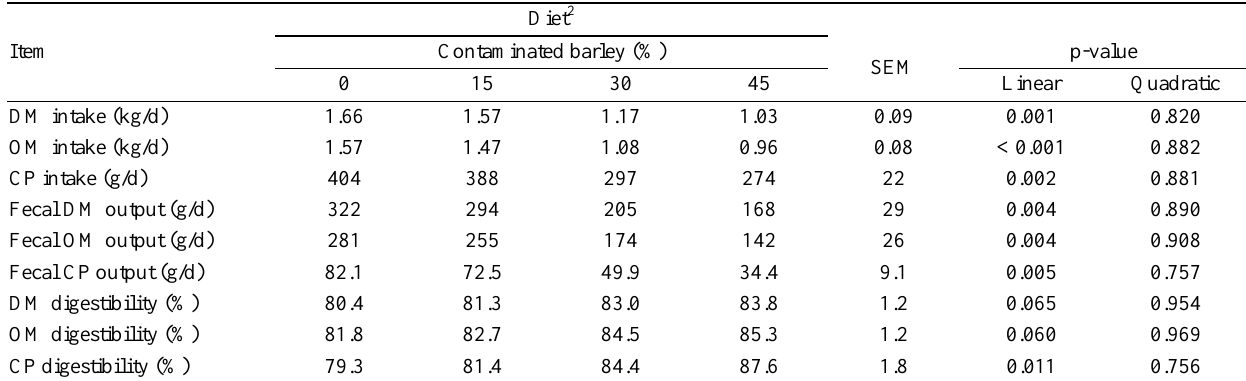
Table 6. Dry matter (DM), organic matter (OM), and crude protein (CP) digestibility of pigs fed experimental diets containing increasing amounts of barley naturally contaminated with Fusarium mycotoxins 1 , Exp. 1